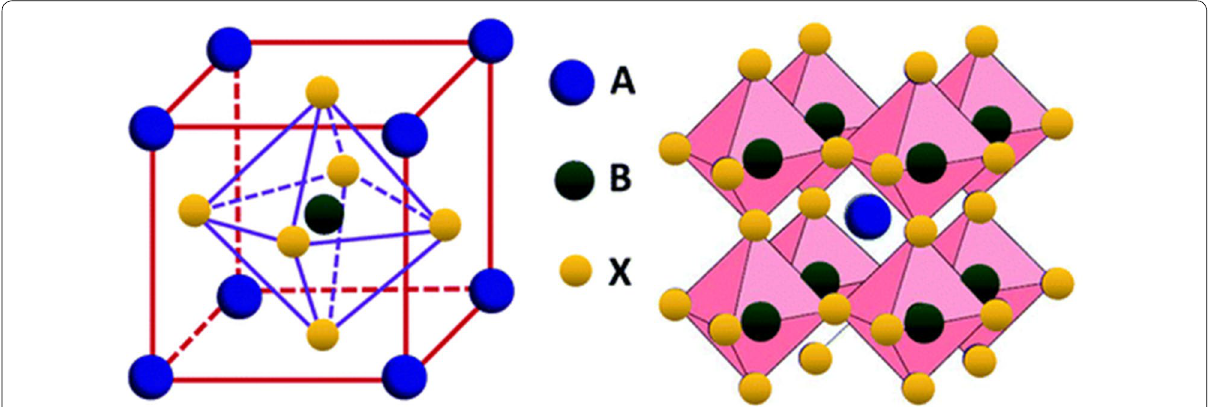
Fig. 23 Perovskite structure ABX 3 (Reproduced with permission from Ref. [67] Copyright © 2019, Royal Society of Chemistry)